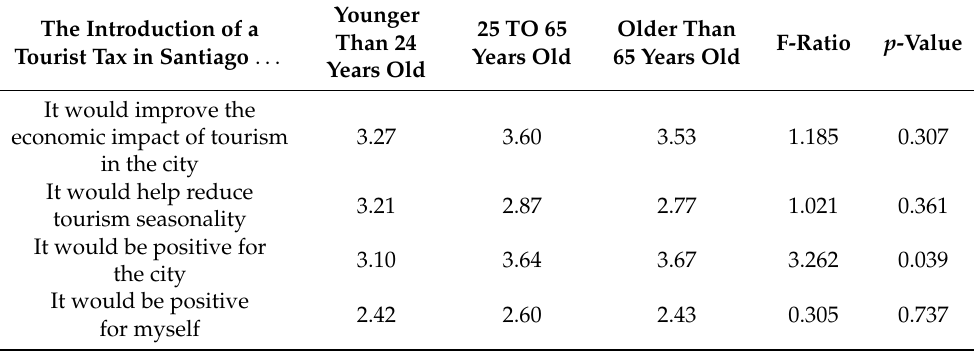
Table 7. Perception of the implementation of the tourist tax according to age group.